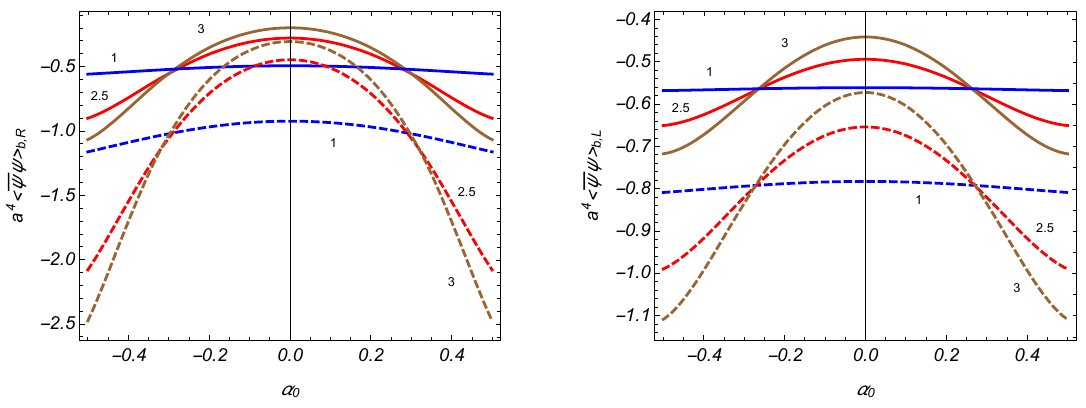
Figure 1 . Brane-induced FC versus the fractional part of the ratio of the magnetic flux to the flux quantum for different values of the parameter q (numbers near the curves). The left and right panels correspond to the R- and L-regions with w/w 0 = 1 . 5 and w/w 0 = 0 . 75, respectively. The full and dashed curves present the FC for the fields s = +1 and s = for ma = 1 and r/w 0 = 0 .